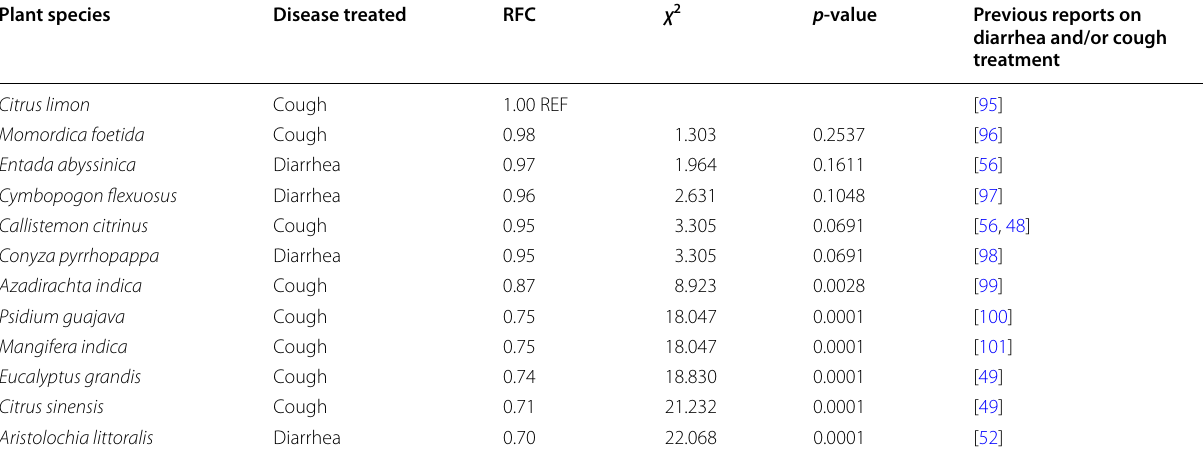
χ 2 : Chi-square; RFC: relative frequency of citation; REF: reference value